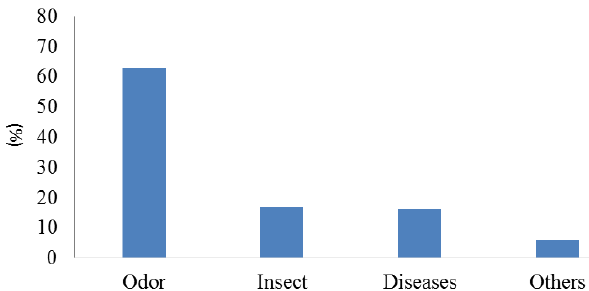
Fig. 7. Respondents opinions of the environmental effects of